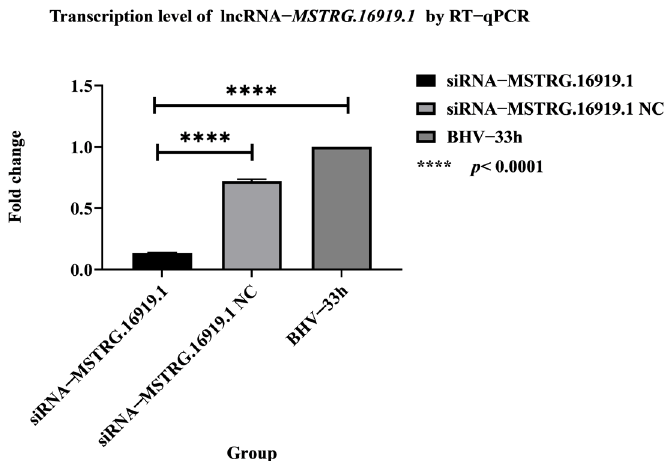
Figure 1. lncRNA − MSTRG.16919.1 silencing effect detection. siRNA − MSTRG.16919.1 is the experi- Figure 1. lncRNA− MSTRG.16919.1 silencing effect detection. siRNA−MSTRG.16919.1 is the experi- mental group in which MDBK cells were infected with BHV − 1 for 33 h and lncRNA − MSTRG.16919.1 mental group in which MDBK cells were infected with BHV−1 for 33 h and lncRNA− MSTRG.16919.1 silenced; siRNA−MSTRG.16919.1 MDBK cells infected with BHV−1 for 33 h and silencing an unre- silenced; siRNA − MSTRG.16919.1 MDBK cells infected with BHV − 1 for 33 h and silencing an unre- lated seque nce is the negative control group of the siRNA− MSTRG.16919.1 group; the BHV−1 33 h lated sequence is the negative control group of the siRNA − MSTRG.16919.1 group; the BHV − 1 33 h group is MDBK cells infected with BHV−1 for 33 h (reference group). group is MDBK cells infected with BHV − 1 for 33 h (reference